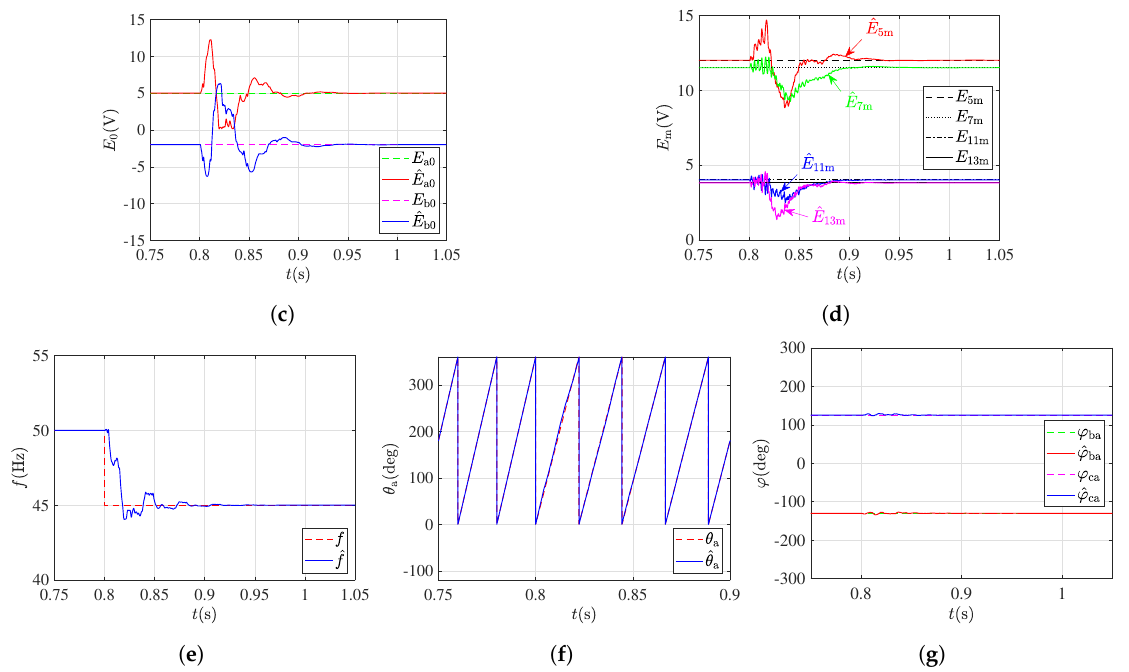
Figure 9. Simulation results when the grid frequency f has a step change from 50 Hz to 45 Hz. The waveforms of ( a ) e abc ; ( b ) ˆ e abc1 . The actual and estimated parameters of ( c ) E a0 , E b0 ; (d) E 5m , E 7m , E 11m , E 13m ; ( e ) f ; ( f ) θ a ; ( g ) ϕ ba , ϕ ca